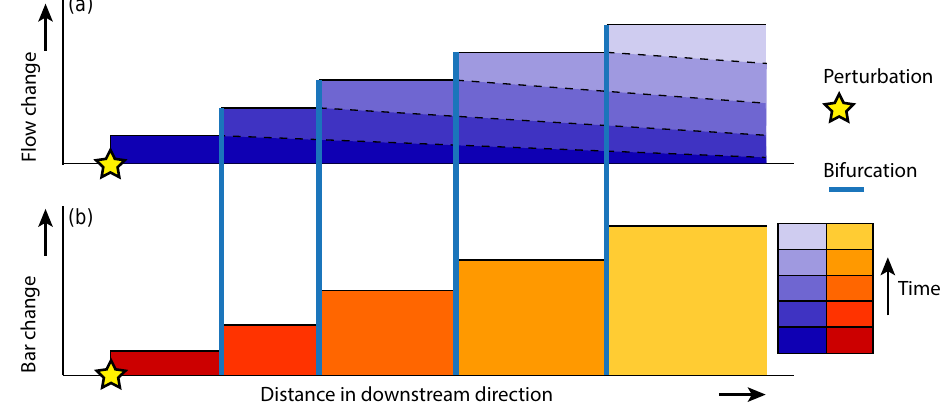
Figure 16. Responses to a disturbance in a braiding river: (a) hydrodynamic response by means of a change in approaching flow direction and discharge division over bifurcations and (b) morphological response by means of bar shape adjustment.